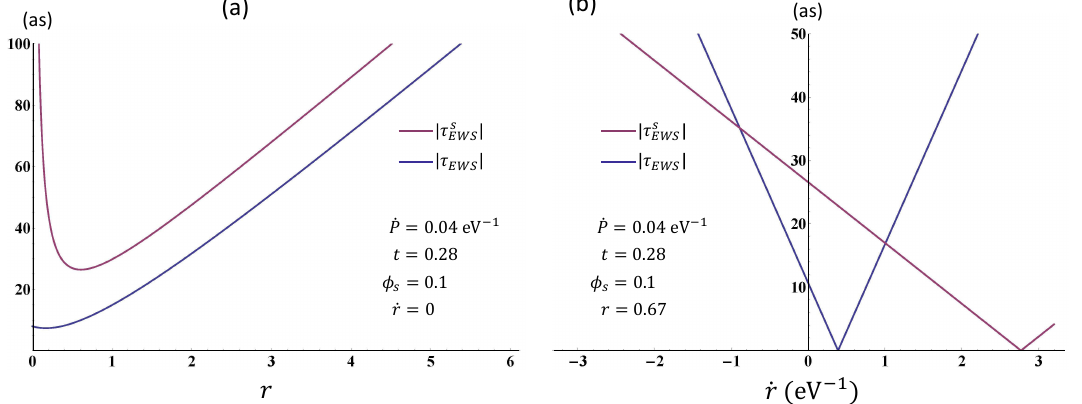
| (blue) and | τ s | (red) as a function of r , for Figure 5: (a) Plot of | τ EWS EWS = 0.1, where in this case ˙ r = 0. (b) Plot of | τ ˙ P = 0.04 eV − 1 , t = 0.28 and φ s | (red) as a function of ˙ r , for r = 0.67 and same values as in (a) for (blue) and | τ s EWS the other parameters [ from Eqs. (26) and (27) ]